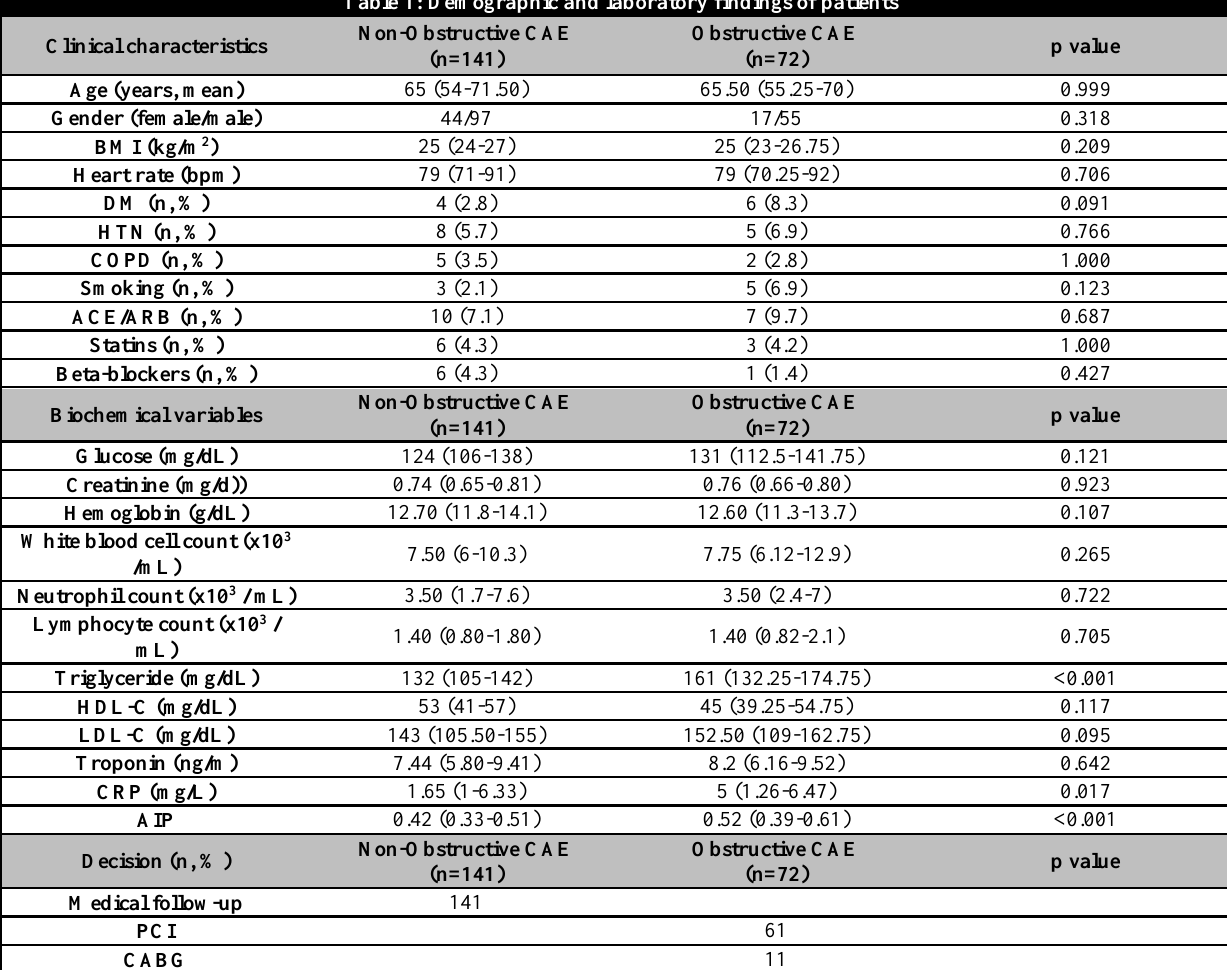
Table 1: Demographic and laboratory findings of patients Clinical